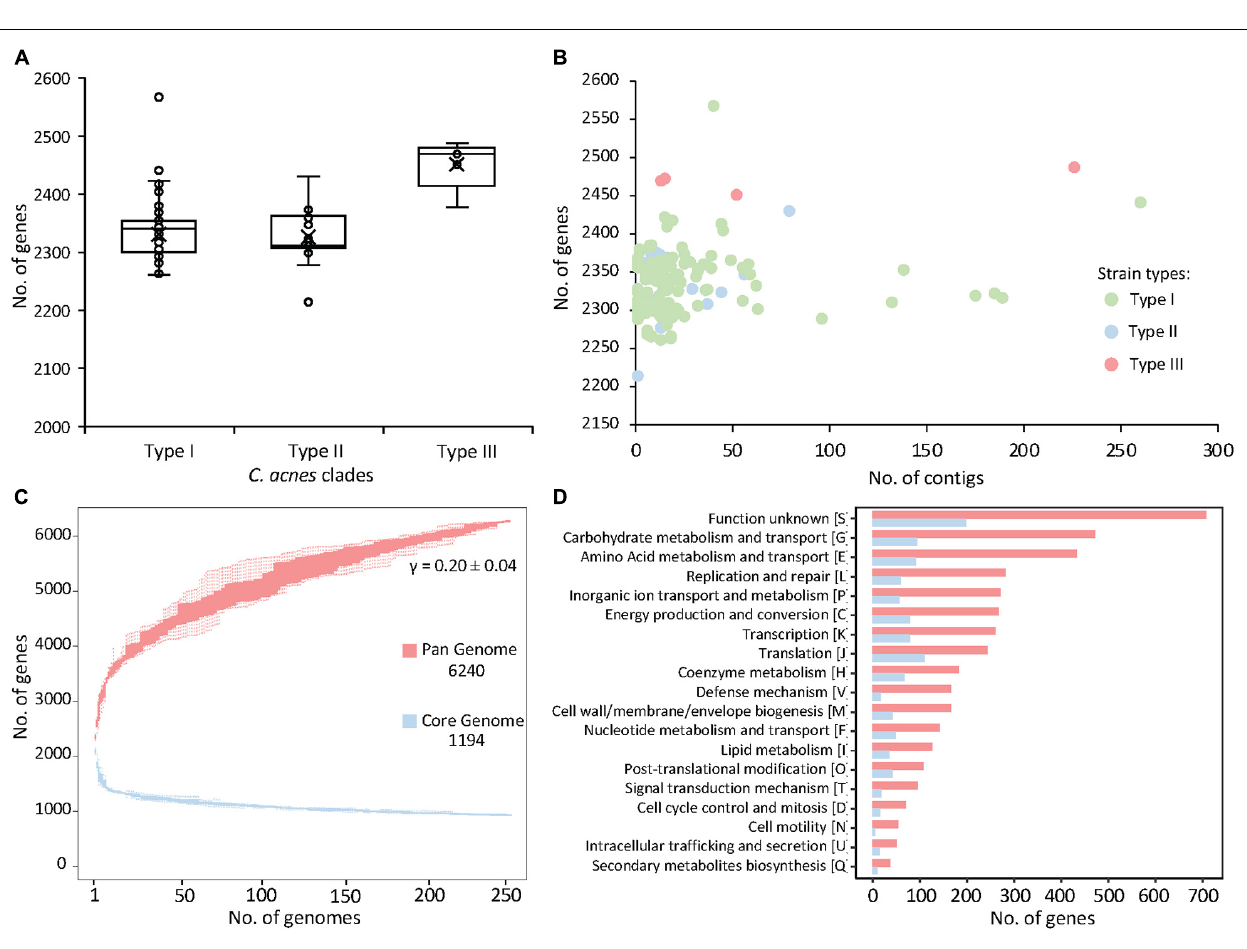
of 6,240 genes representing the pan genome of 255 C.